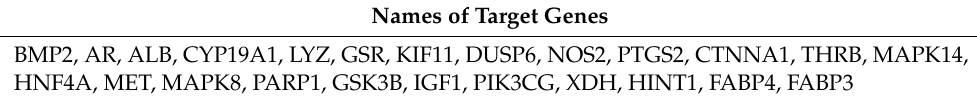
Figure 6. Molecular docking analysis of potential core anti-PRRSV targets of sanguinarine. ( a ) Schematic diagram of theoretical binding mode of sanguinarine and ALB, AR, MAPK8, MAPK14, IGF1, GSK3B, PTGS2, or NOS2. ( b ) The docking results of sanguinarine to ALB, AR, MAPK8, MAPK14, IGF1, GSK3B, PTGS2, or NOS2. Table 2. The potential anti-PRRSV targets of sanguinarine. Names of Target